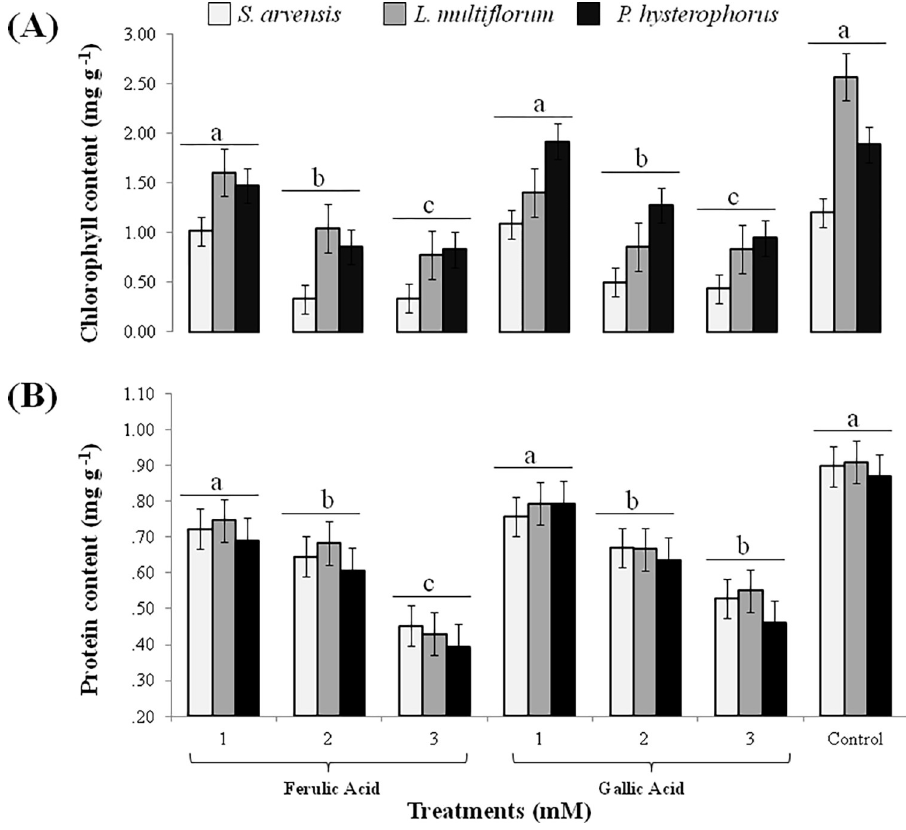
Fig 3. Total chlorophyll and total protein contents of weeds in response to 1, 2 and 3 mM FA and GA. (A) chlorophyll content; (B) protein content. Values are presented as mean ± SE (n = 10). Bar values with different letters differ significantly from each other at P <